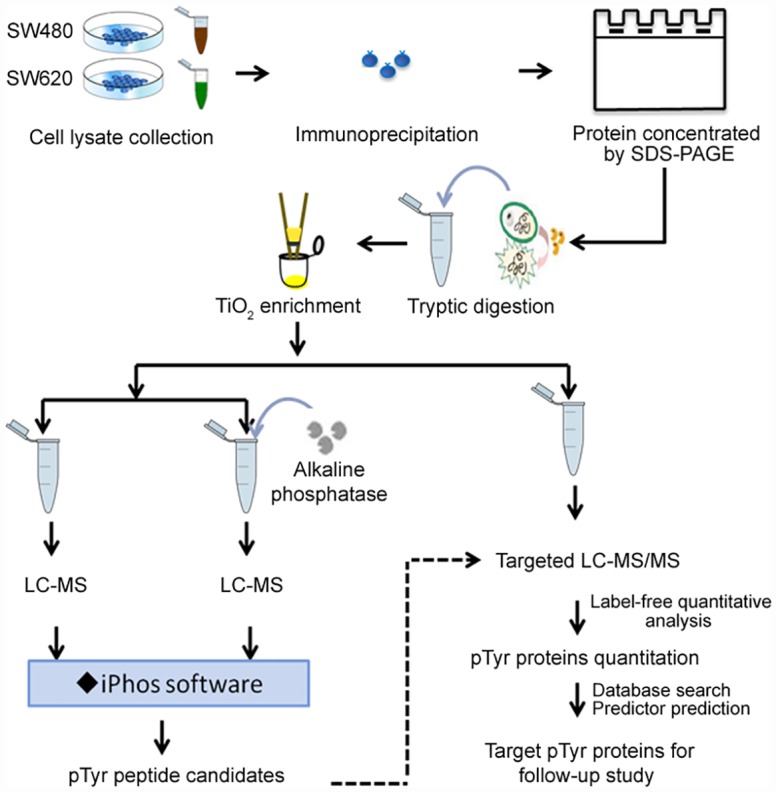
Experimental flowchart for the analysis of pTyr proteins in colorectal cancer cell lines.